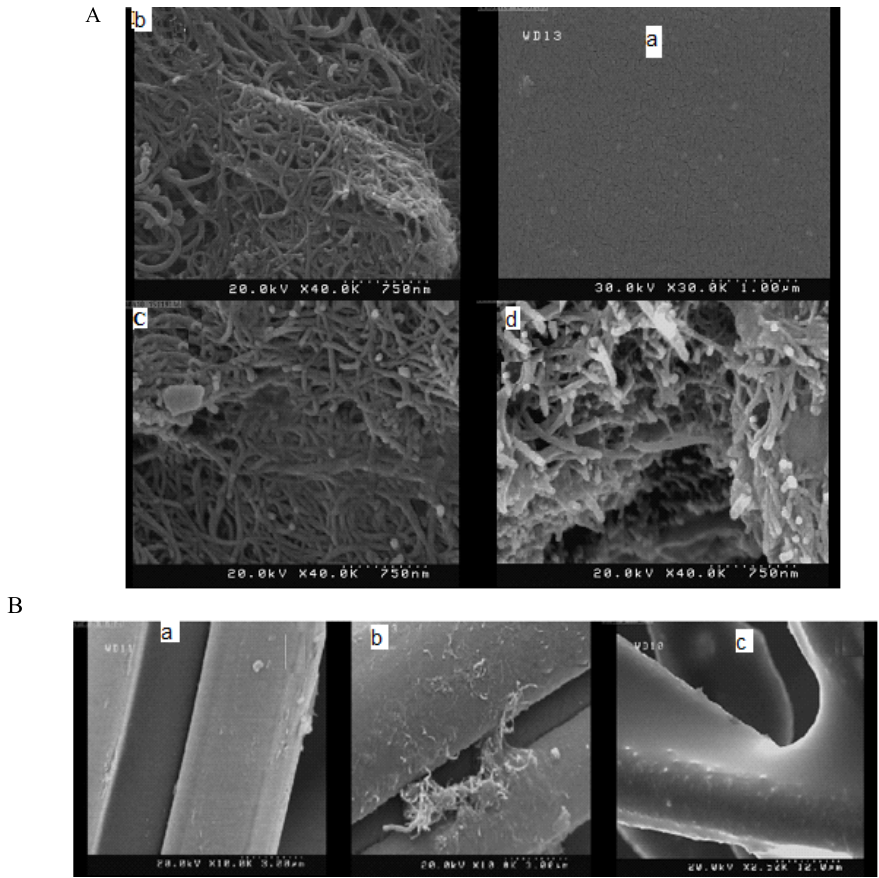
Fig. 4: (A) FESEM images of (a) bare GC, (b) HOOC-MWCNT/GC; (c) emim Tf MWCNT/GC and (d) ADH/emim